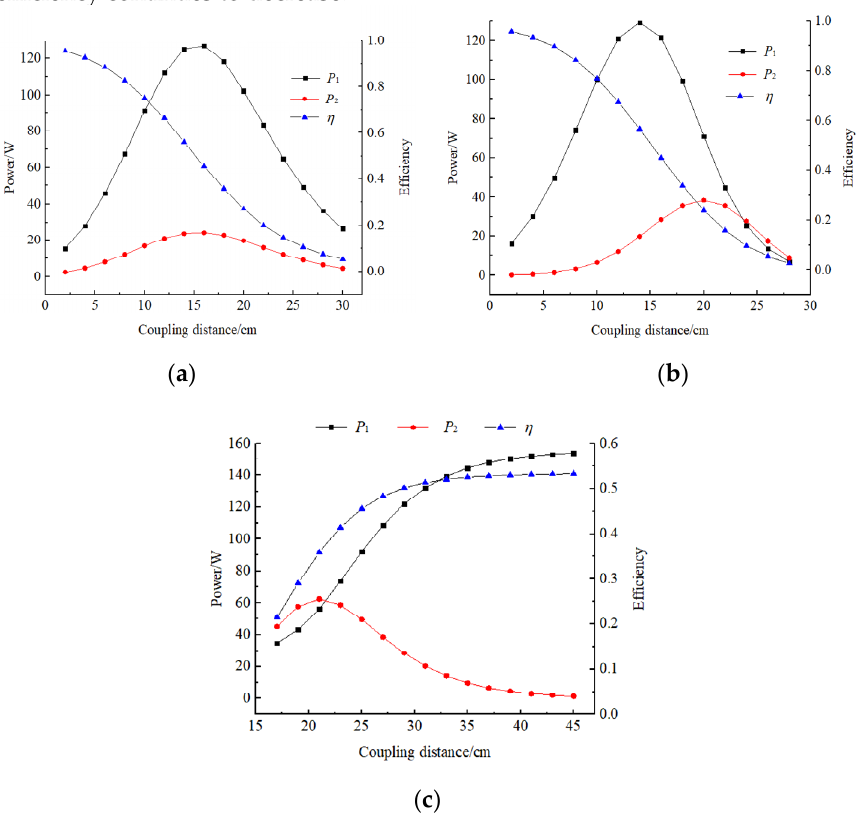
Figure 7. The relationship between the coupling distance on the different sides of the coaxial and the system parameters. ( a ) l 1 , l 2 change synchronously. ( b ) Only l 1 changes. ( c ) Only l 2 changes.